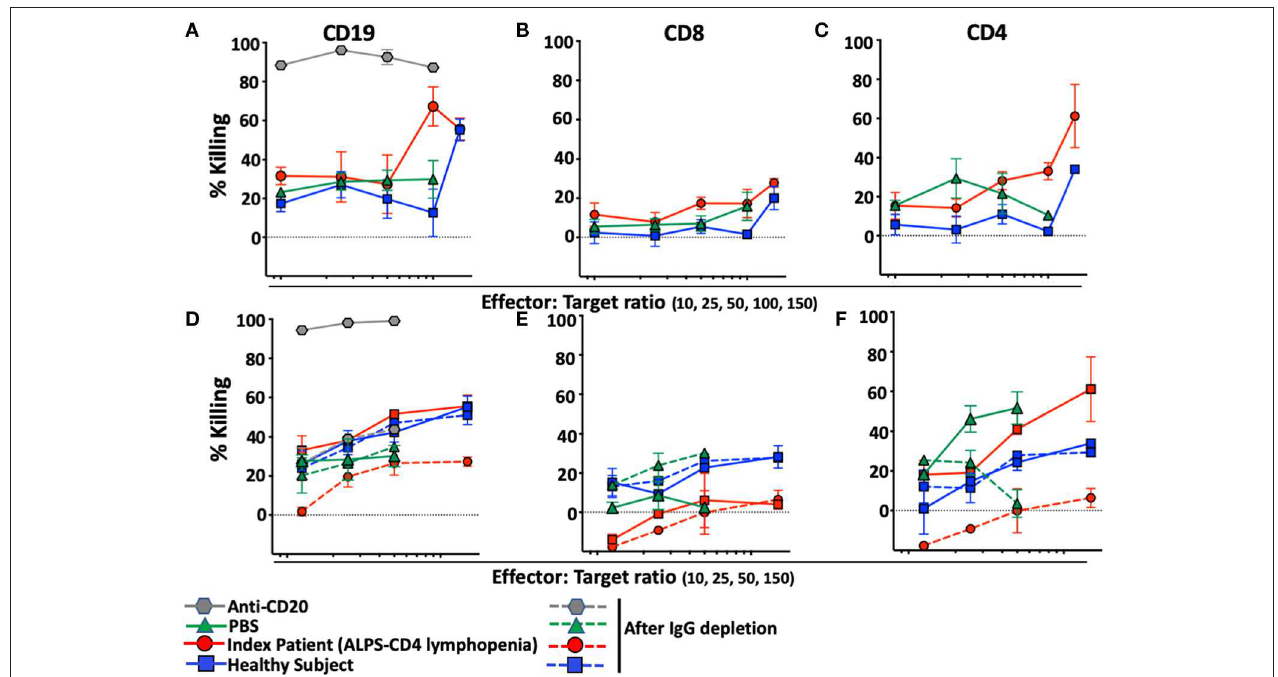
FIGURE 5 | NK-mediated antibody dependent direct cytotoxicity of CD19, CD4, or CD8 T-cells in the index patient with ALPS-FAS and CD4 lymphopenia. Killing is expressed as percentage of untreated control. CSFE-stained healthy donor cells after incubation at different E:T ratio with autologous NK cells in presence of monoclonal antibody Anti-CD20 (positive control for NK mediated ADCC, gray hexagon), PBS (green triangle), and plasma from healthy control (blue square) or index patient (red circle) with ALPS and CD4 lymphopenia. (A–C) NK-mediated killing of CD19 B-cells, CD8 T-cells, CD4 T-cells, respectively. Presented is average ± standard error of the mean (SEM) of 3 independent experiments each with 2 replicates per experimental condition. (D–F) NK-mediated killing of CD19 B-cells, CD8 T-cells, CD4 T-cells before and after incubation with Protein A/G agarose affinity resin for depletion of IgG in each experimental condition. Presented is average ± SEM of 2 replicates per experimental